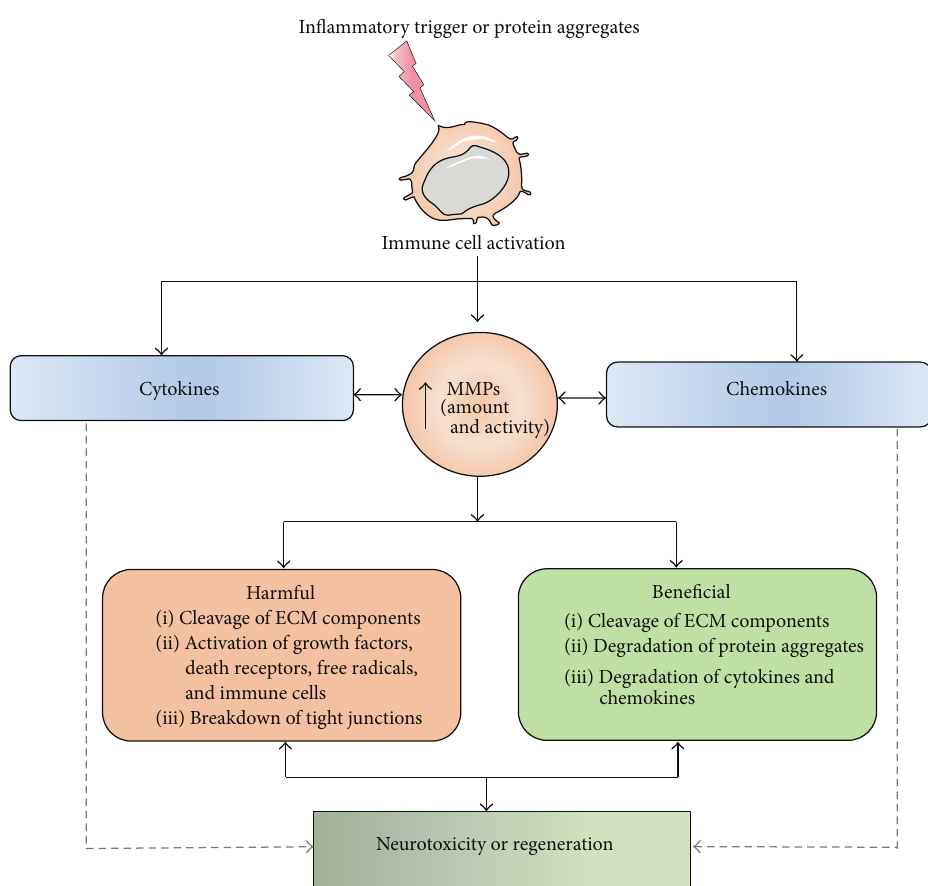
Figure 2: Schematic representation of the activation of MMPs, their interactions with cytokines and chemokines, and the outcome of the interactions. MMPs are induced and activated in the presence of an external trigger (e.g., inflammatory stimuli) or abnormal proteins (e.g., protein or peptide aggregates). The activated MMPs can alter the properties of cytokines and chemokines. They also interact with the extracellular matrix, cell surface receptors, growth factors, integrin, signaling molecules, and tight junction proteins and alter their properties. This affects neuroinflammation, cell death or survival, growth, and regeneration. ECM, extracellular matrix; MMP, matrix metalloproteinase; TJs, tight